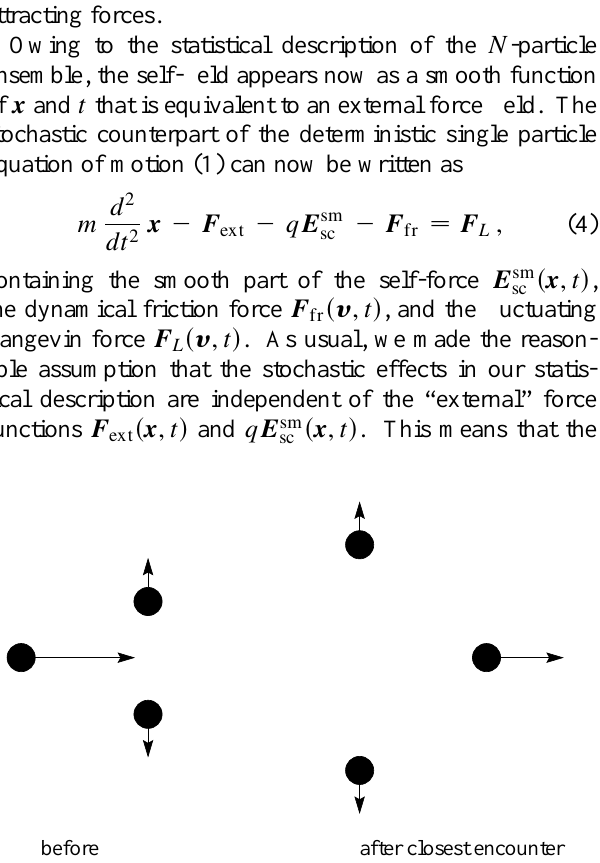
FIG. 1. Sketch of the mechanism of dynamical friction for repelling forces between